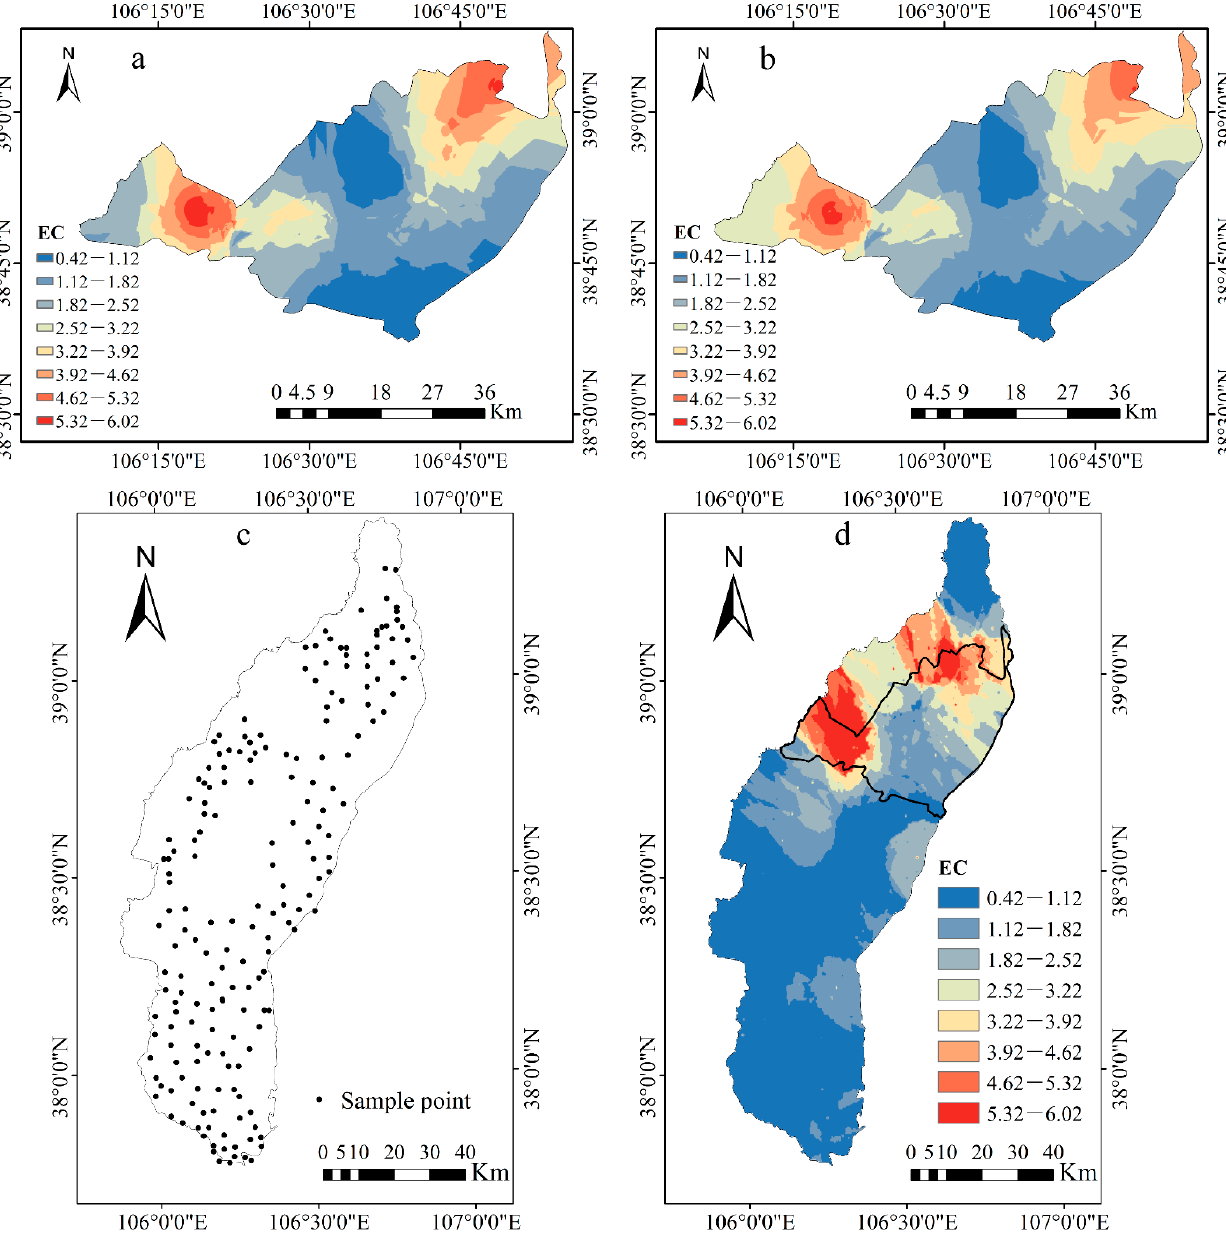
Figure 11. Spatial distribution of soil EC ( a ) measured value, ( b ) ERT of study area, ( c ) sample point in Yinchuan Plain, ( d ) measured value in Yinchuan Plain. in Yinchuan Plain, ( d ) measured value in Yinchuan